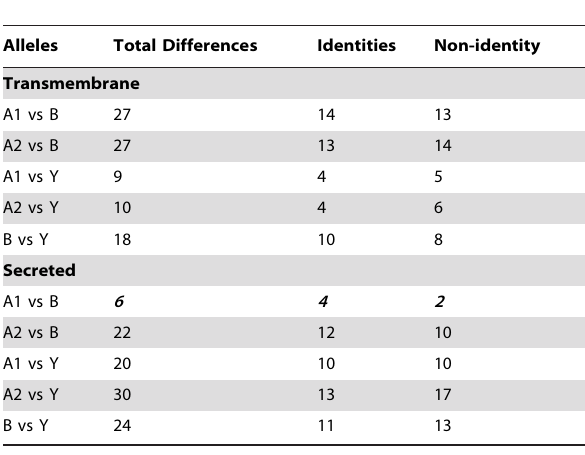
Table 4. Amino Acid Changes in Cross